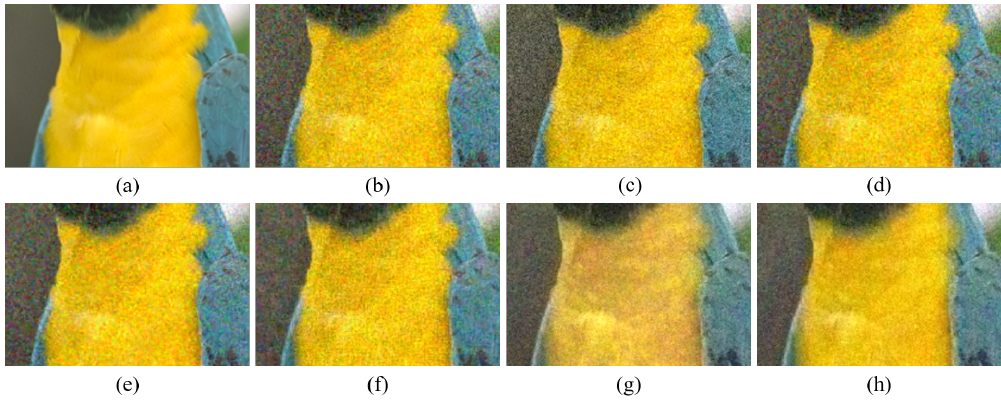
Figure 17. Showing the enlarged regions of Figure 16. ( a ) Original ( b ) ICC [12], ( c ) DNet [13] ( d ) RI